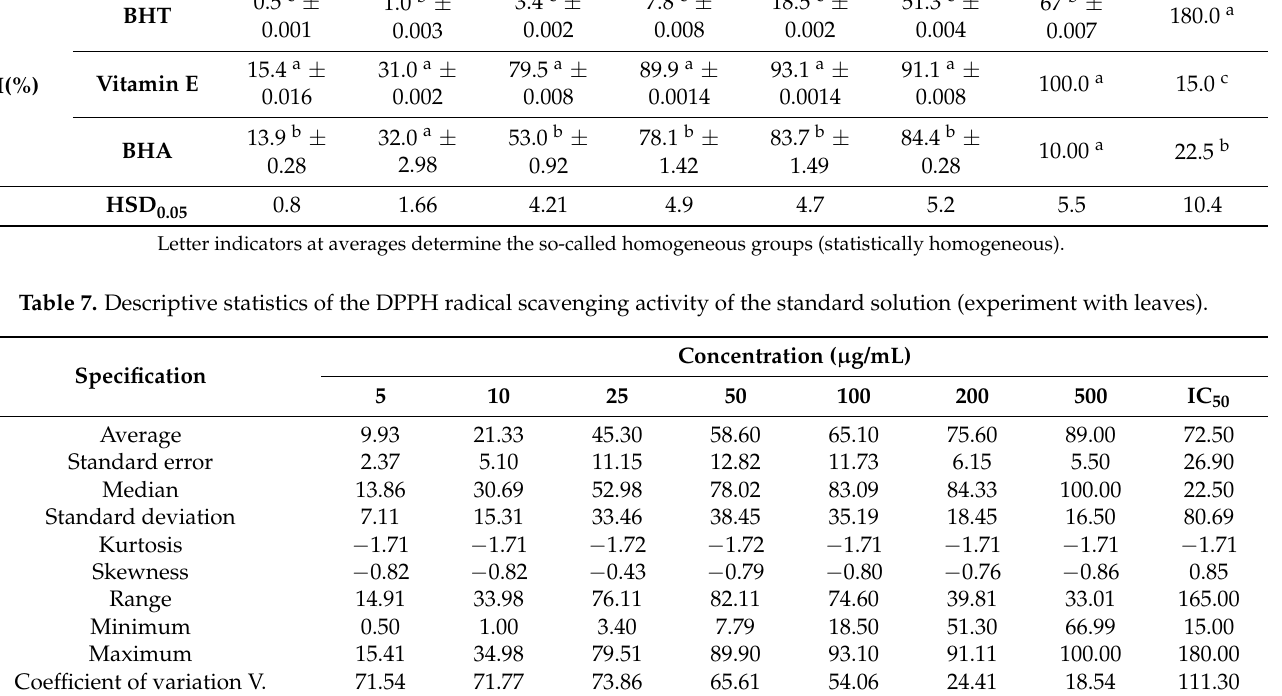
Table 6. DPPH radical scavenging activity of standard solution (experiment with leaves of the plant). Concentration ( µ g/mL) Specification